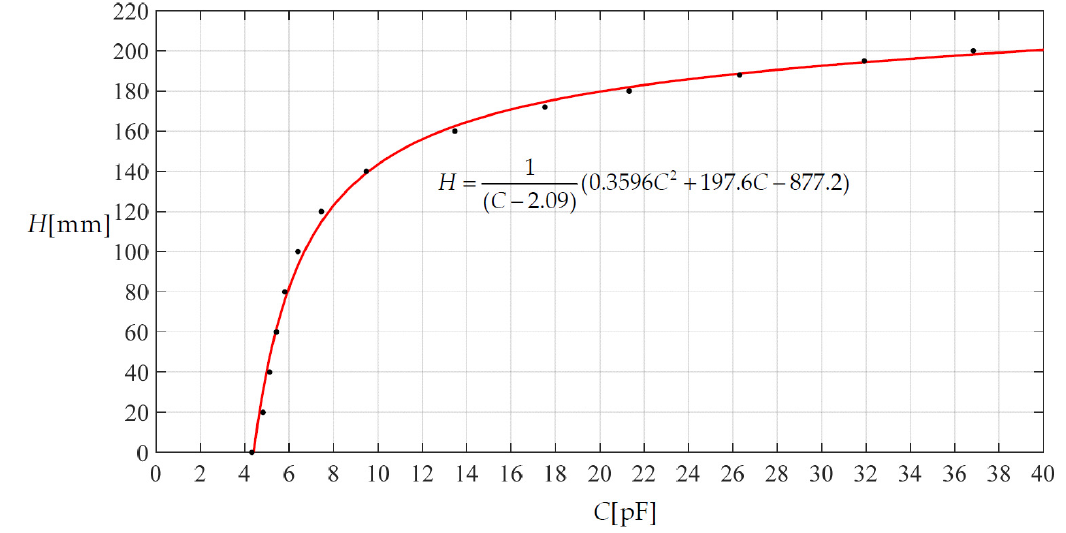
Figure 11. A scatter diagram describing the relationship of height H and capacitance C